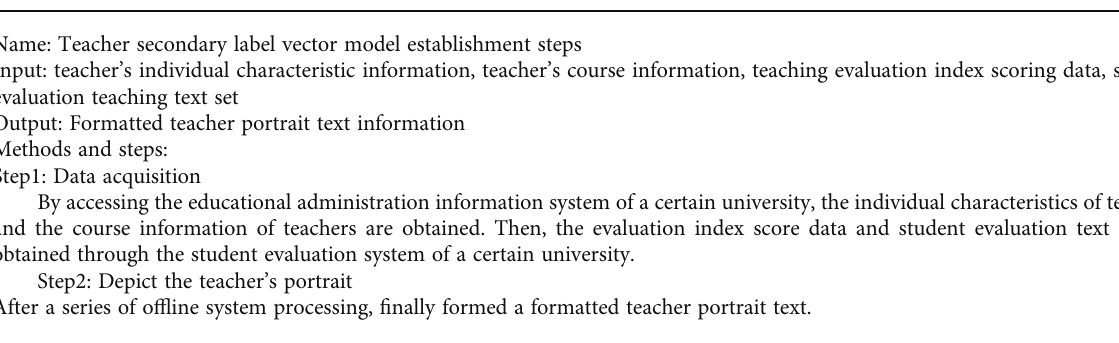
Algorithm 2: Steps for establishing the vector model of teacher ’ s secondary label.